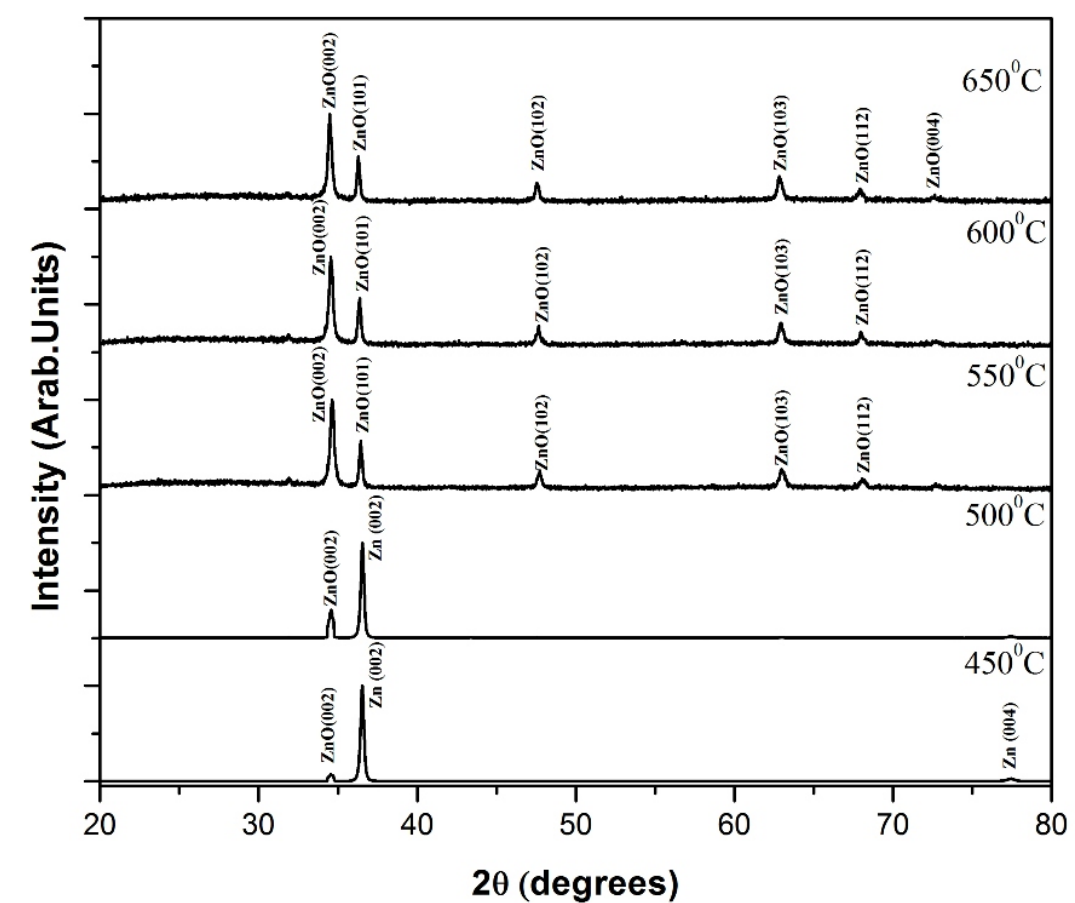
Figure 1. XRD patterns of the ZnO nanowires prepared by the oxidation of Zn thin films at temperatures ranging from 450 °C to 650